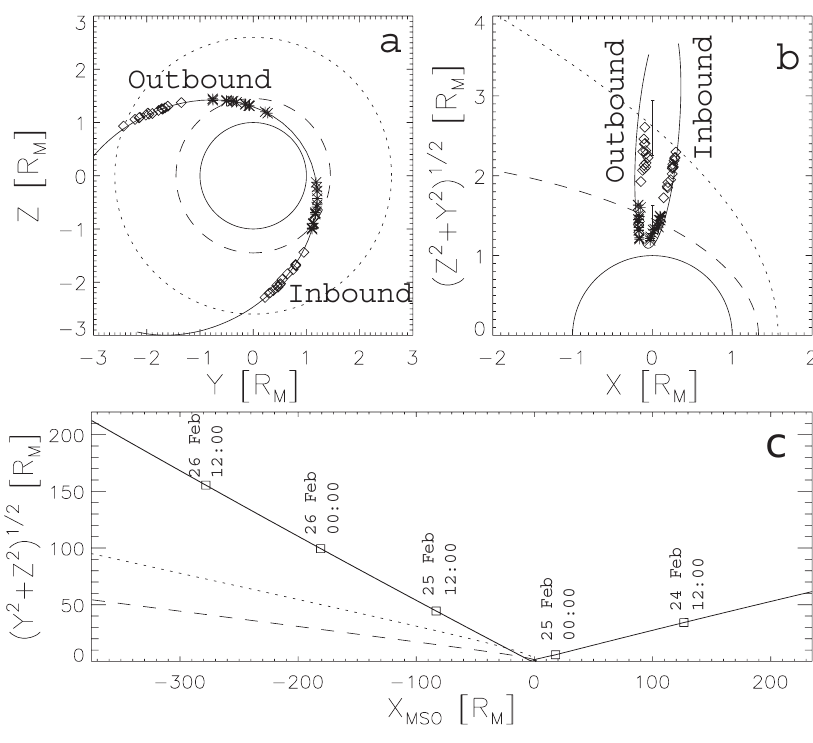
Fig. 1. Boundary crossing locations and orbital geometry during the Rosetta Mars swingby. The panels show all BS (diamonds) and MPB (stars) crossings observed by MEX during 24–27 February 2007, projected onto (a) the y-z plane and (b) in cylindrical coordinates together with the average BS (dotted line) and MPB (dashed line) as well as (c) the trajectory of Rosetta in cylindrical coordinates (black solid line) together with best fits of the MPB (dashed line) and BS (dotted line) from Trotignon et al. (2006). A part of the MEX orbit is shown in panels (a) and (b) (black line). The vertical bars in panel (b) indicate the mean extrapolated terminator distance and standard deviation of the BS and MPB crossings from Edberg et al. (2008). The positions of the crossings are adjusted to account for the 4 ◦ aberrated solar wind flow caused by the orbital motion of the planet with respect to an average solar wind speed of 400kms − 1